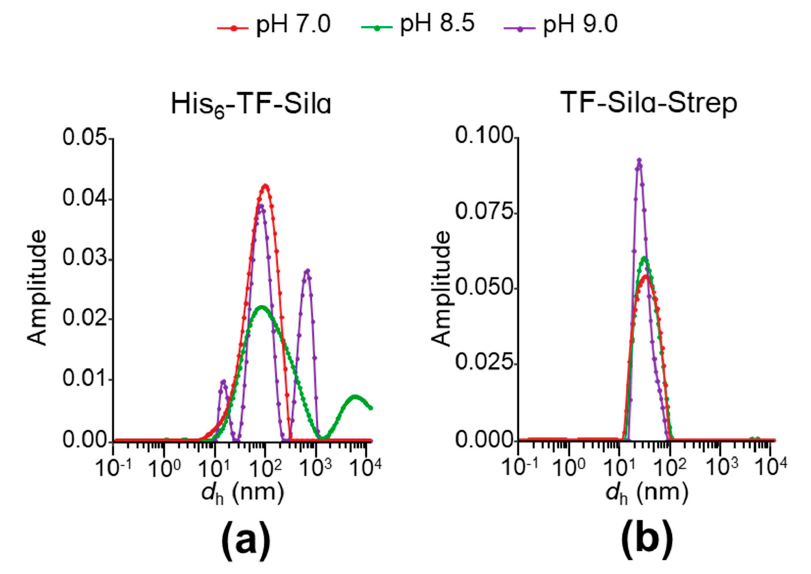
Figure 4. Dynamic light scattering measurements of ( a ) His 6 -TF-Sil α ; ( b ) TF-Sil α -Strep. Graphs of amplitude against hydrodynamic diameter ( d h ) for the respective proteins in the buffers listed in Table 3 are shown.